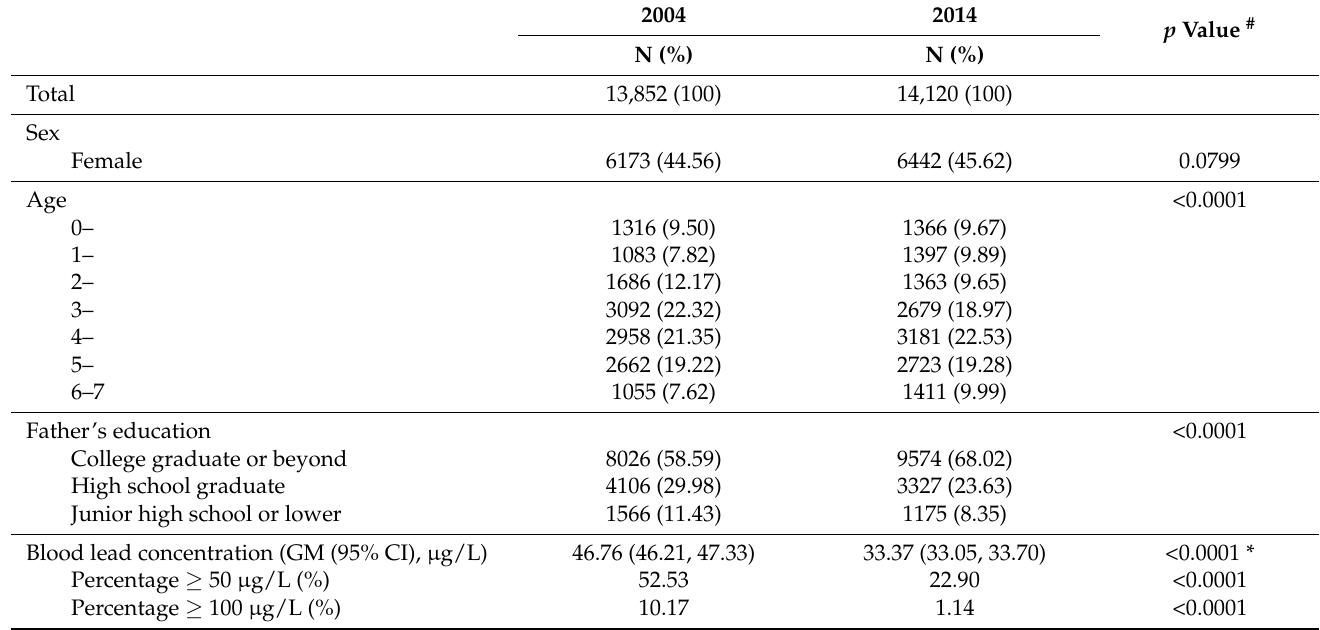
Table 1. Demographics and blood lead levels of participants for two time